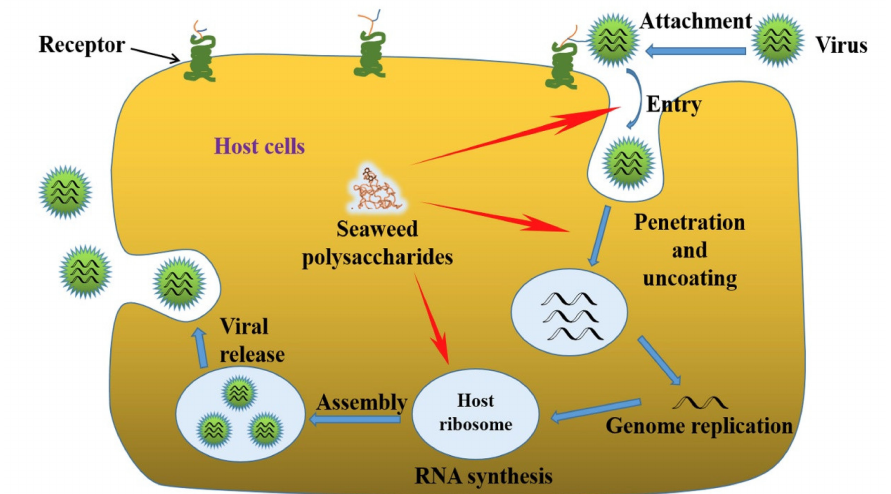
Figure 2. Viral infection and the antiviral phase of seaweed polysaccharides. Reused with permission, license number: 5265040871103 Adapted with permission from Ref. [140]. ©2017, Elsevier Ltd. All rights